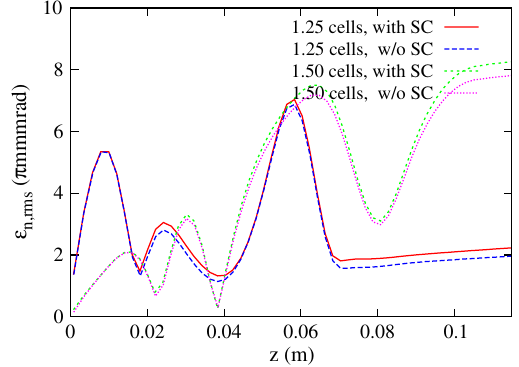
FIG. 7. Beam energy vs cathode cell length.